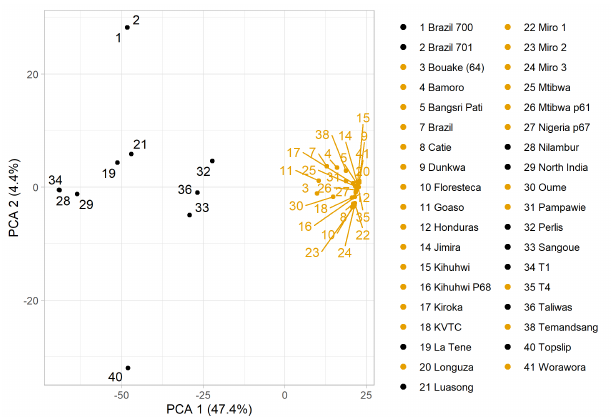
Figure 3. Principal components analysis on genetic distance of the different teak accessions. The different accessions are indicated by numbers, the two main clusters as identified by structure analysis by different